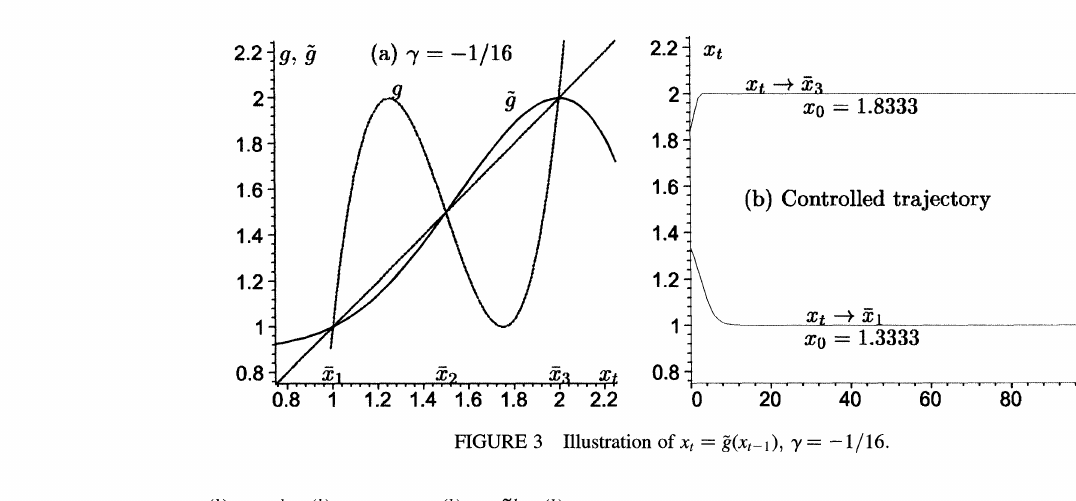
FIGURE 3 Illustration ofxt (xt-1), T- -1/16.